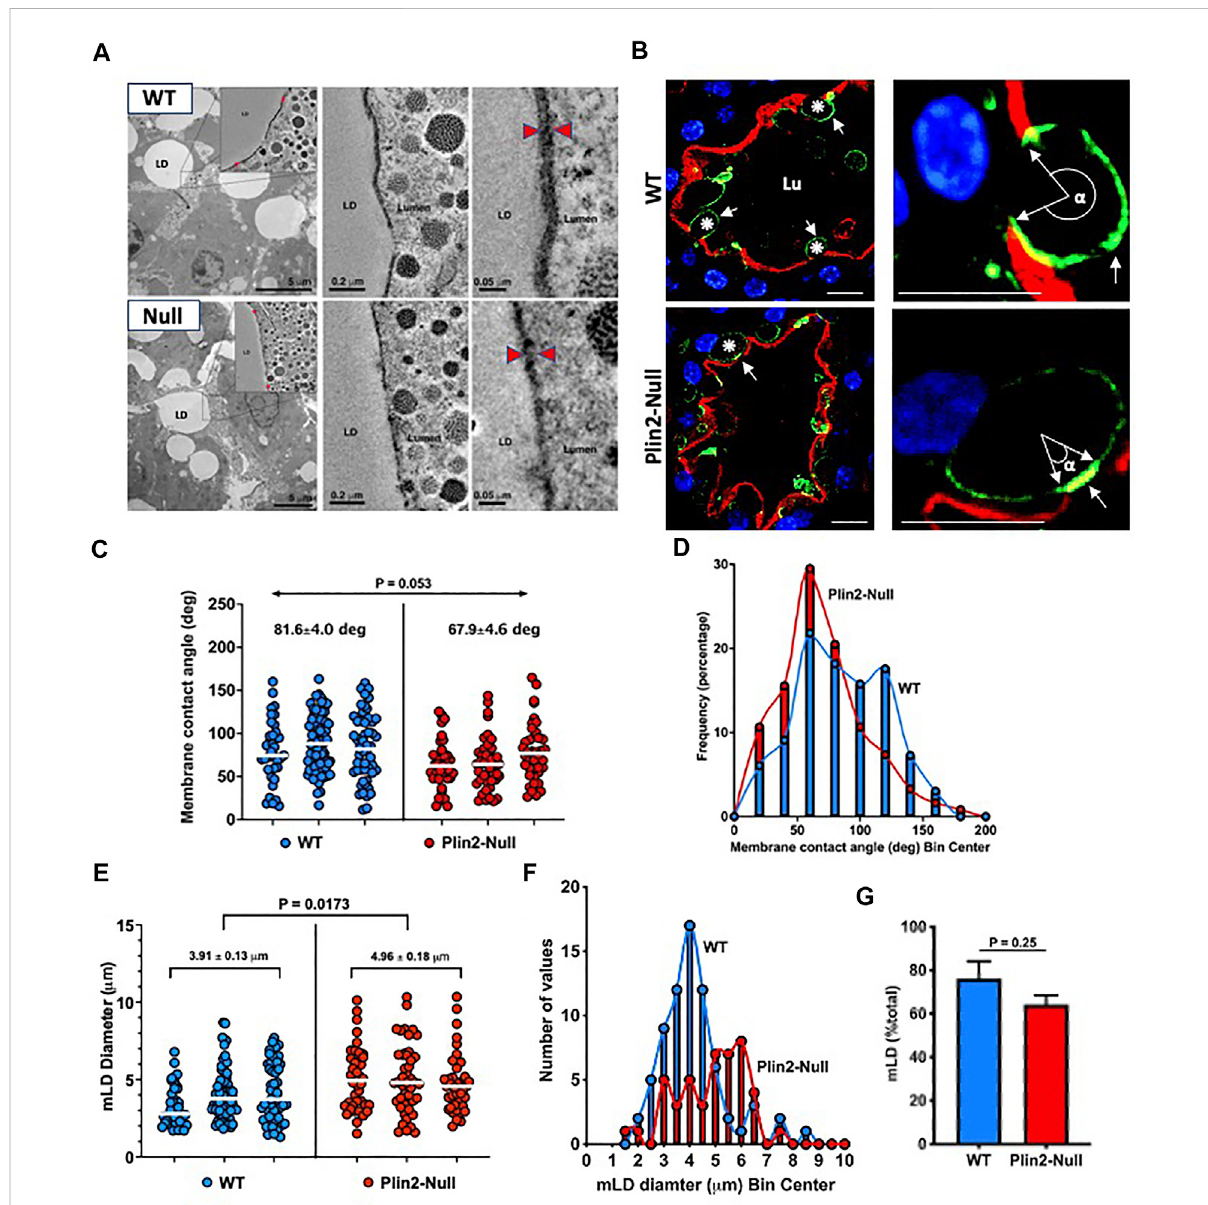
FIGURE 1 LD-APM contacts. (A) Electron tomograms from mammary glands of WT and Plin2-Null dams at L10. Left panels show lower magni fi cation images of mammary alveoli, the box outlines contact between a LD and the apical membrane that is further magni fi ed in insets and subsequent images in the middle and right panels. Red arrowheads in the right panels indicate LD-APM contact zones. Scale bars are indicated in each panel. (B) MammaryalveolifromWTandPlin2-NullmammaryglandsatL10immunostainedforCidea(green)toidentifyLDandwithAlexa594-WGA(red) to identify the apical plasma membrane (APM). Left panels show LD contacting the APM (asterisks). LD-APM contact sites are identi fi ed by Cidea concentration at the APM (white arrows). Right panels are higher magni fi cation images of LD-APM contacts (white arrows) in WT and Plin2-Null sMEC showing membrane contact angles ( α ). Scale bars = 10 µm. (C) LD-APM contact angles quanti fi ed in sMEC from 20 – 40 randomly selected mammary alveoli from 3 WT (blue) and Plin2-Null (red) dams. Horizontal bars indicate median membrane contact angles. Average median membranecontactangles±SEMareshownaboveeachgroup. p valueforgroupdifferencesdeterminedbynested t testisshownatthetopof fi gure. (D) Histogram showing size distributions of membrane contact angles for each genotype. (E) Diameters of LD contacting the APM (mLD) in sMEC from 20 – 40 randomly selected mammary alveoli from 3 WT and Plin2-Null dams. Horizontal bars indicate median diameters. Average median mLD diameters±SEMareshownaboveeachgroup. p -valuesforgroupdifferencesweredeterminedbynested t -testandareshownatthetopof fi gure. (F) Histogram showing the mLD size distribution for each genotype. (G) Percentage of LD contacting the APM. Values are averages ±SEM from sMEC in 20 – 40 randomly selected alveoli from 3 WT and Plin2-Null dams. p -values were determined by Students